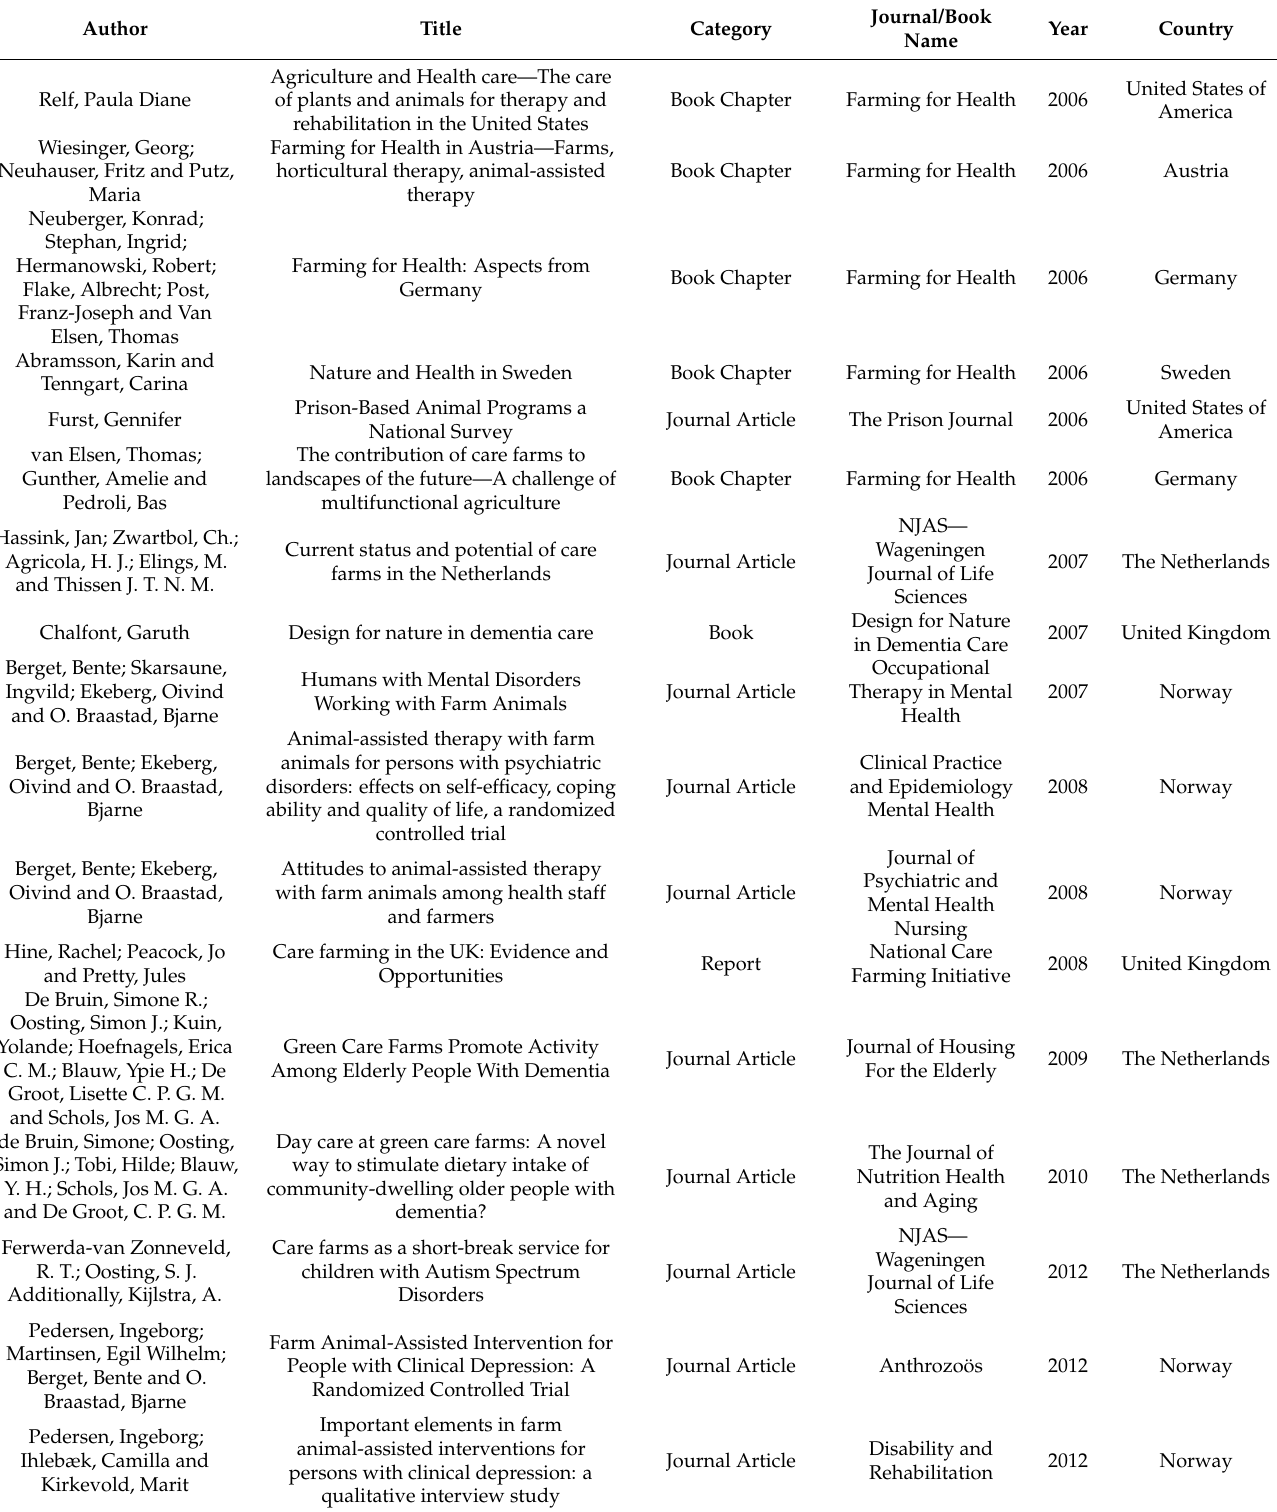
Table A1. List of literature included in chronological